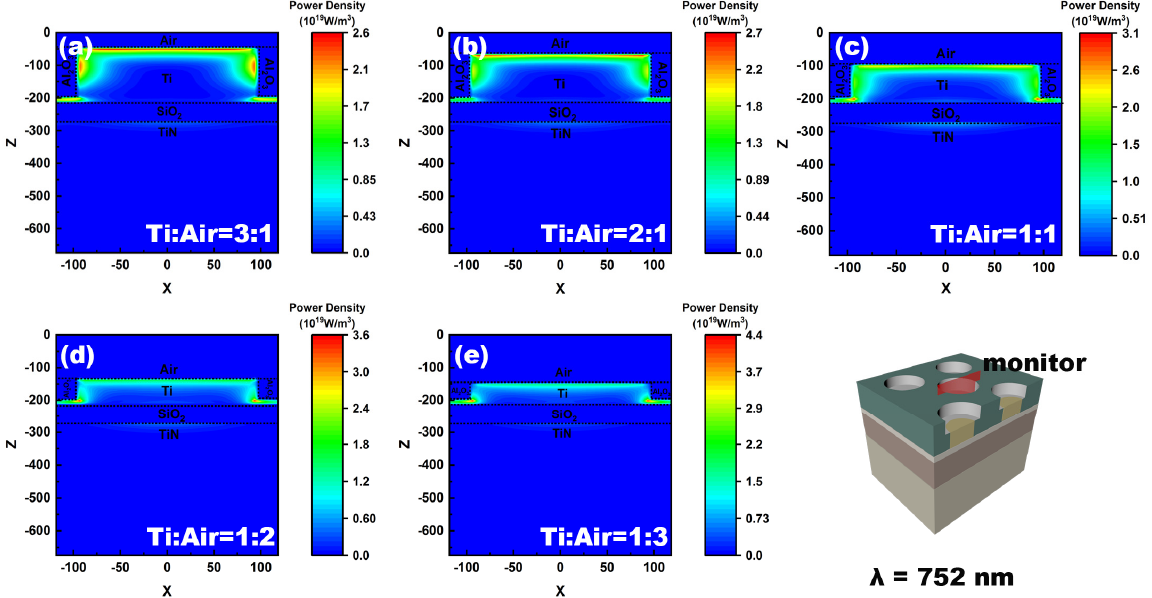
Figure 7. The distributions of absorbed power density in the vertical cross-section at the wavelength of 752 nm as the height ratio of Ti to air nanopillar are 3:1 ( a ), 2:1 ( b ), 1:1 ( c ), 1:2 ( d ), and 1:3 ( e ), respectively. The total height is fixed to 200 nm. The diameters of Ti and air nanopillars are fixed to 95 nm and 120 nm. The last subfigure shows the monitor position.